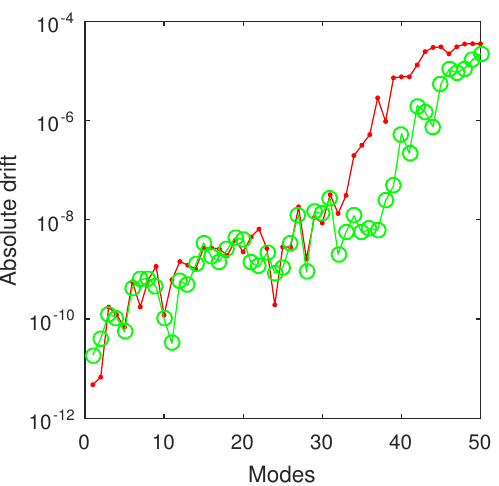
Figure 9. The absolute drift with respect to N of the first 50 negative eigenvalues of the hydrogen atom eigenproblems (1), (5), and (6) computed by mapped ChC with scaling factor c : = 2 and N 1 : = 1600 and N 1 : = 2048 (red line). The green circled line signifies the drift of eigenvalues computed by mapped ChC using N : = 2048 with respect to the exact eigenvalues λ n = − 1/ ( 2 n + 4 ) 2 , n = 0,1,2, . . . ,50 corresponding to l : =